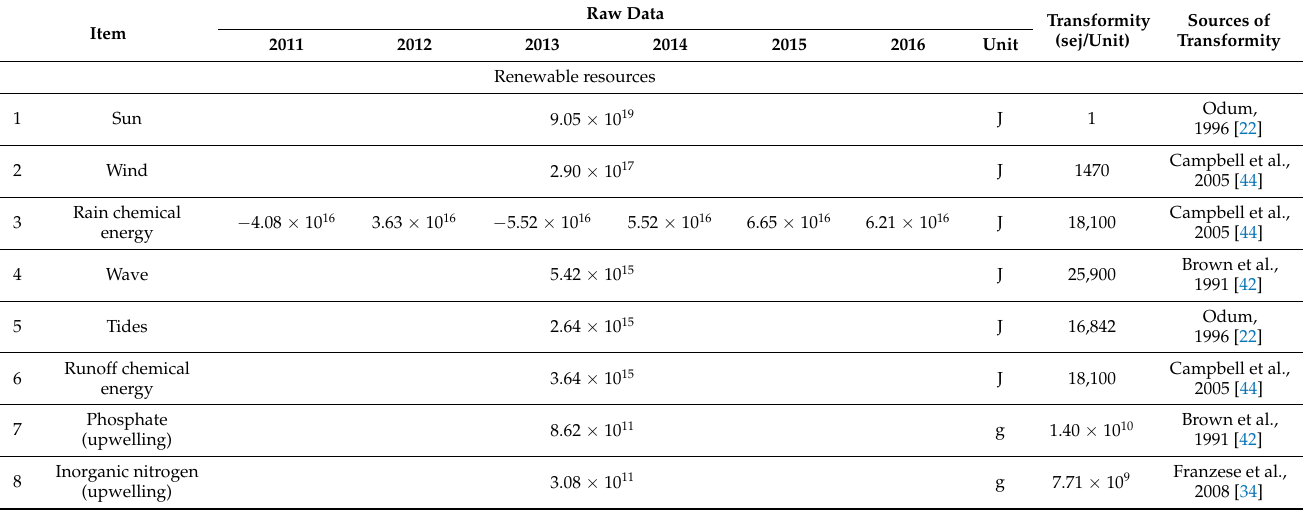
Table A2. The raw data of emergy flows of Zhoushan sea area during